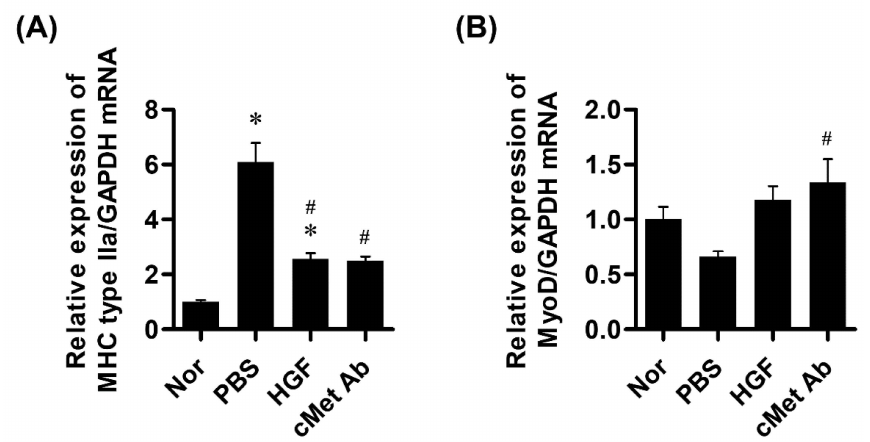
Figure 4. Results of real-time PCR of myogenesis-related genes. ( A ) The expression level of myosin heavy chain IIa. ( B ) The expression level of MyoD. * p <0.05 compared to Nor (normal); # p <0.05 compared to